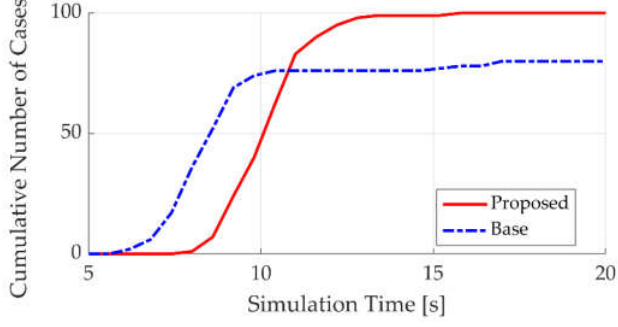
Figure 12. Simulation time to cross the intersection.